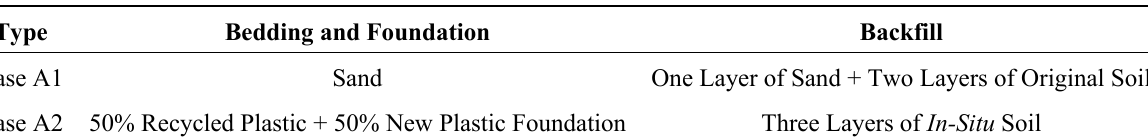
Table 7. Cases for the first field test.